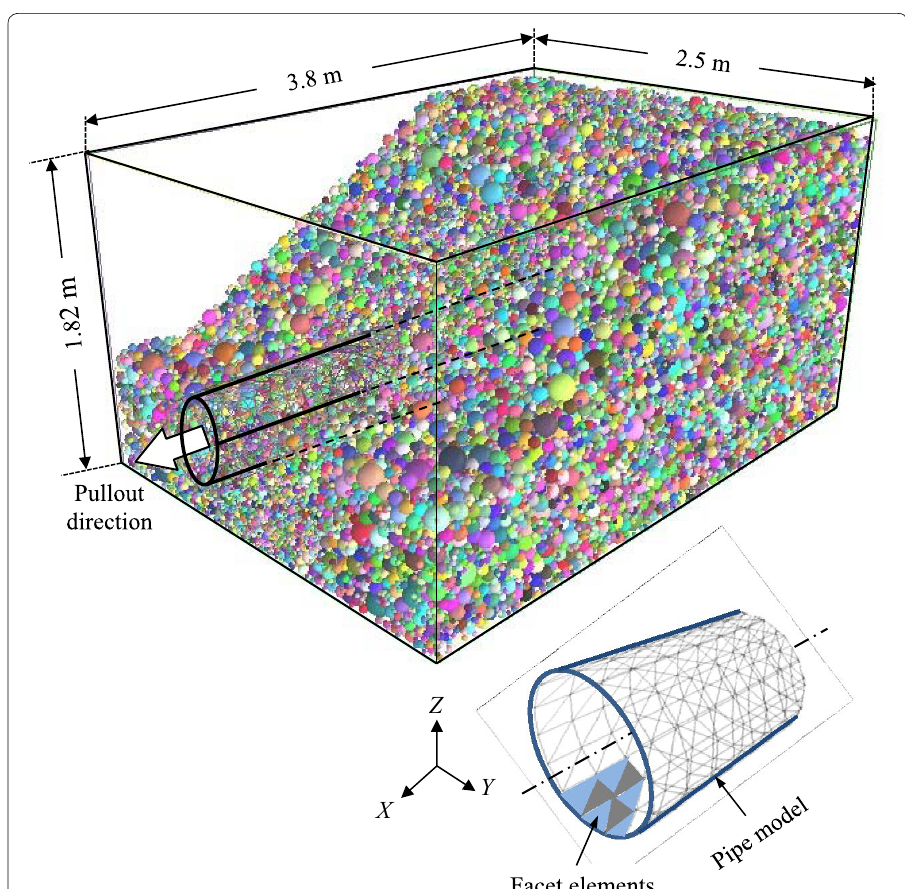
Fig. 3 Cut-out view of the model showing the pipeline and the surrounding